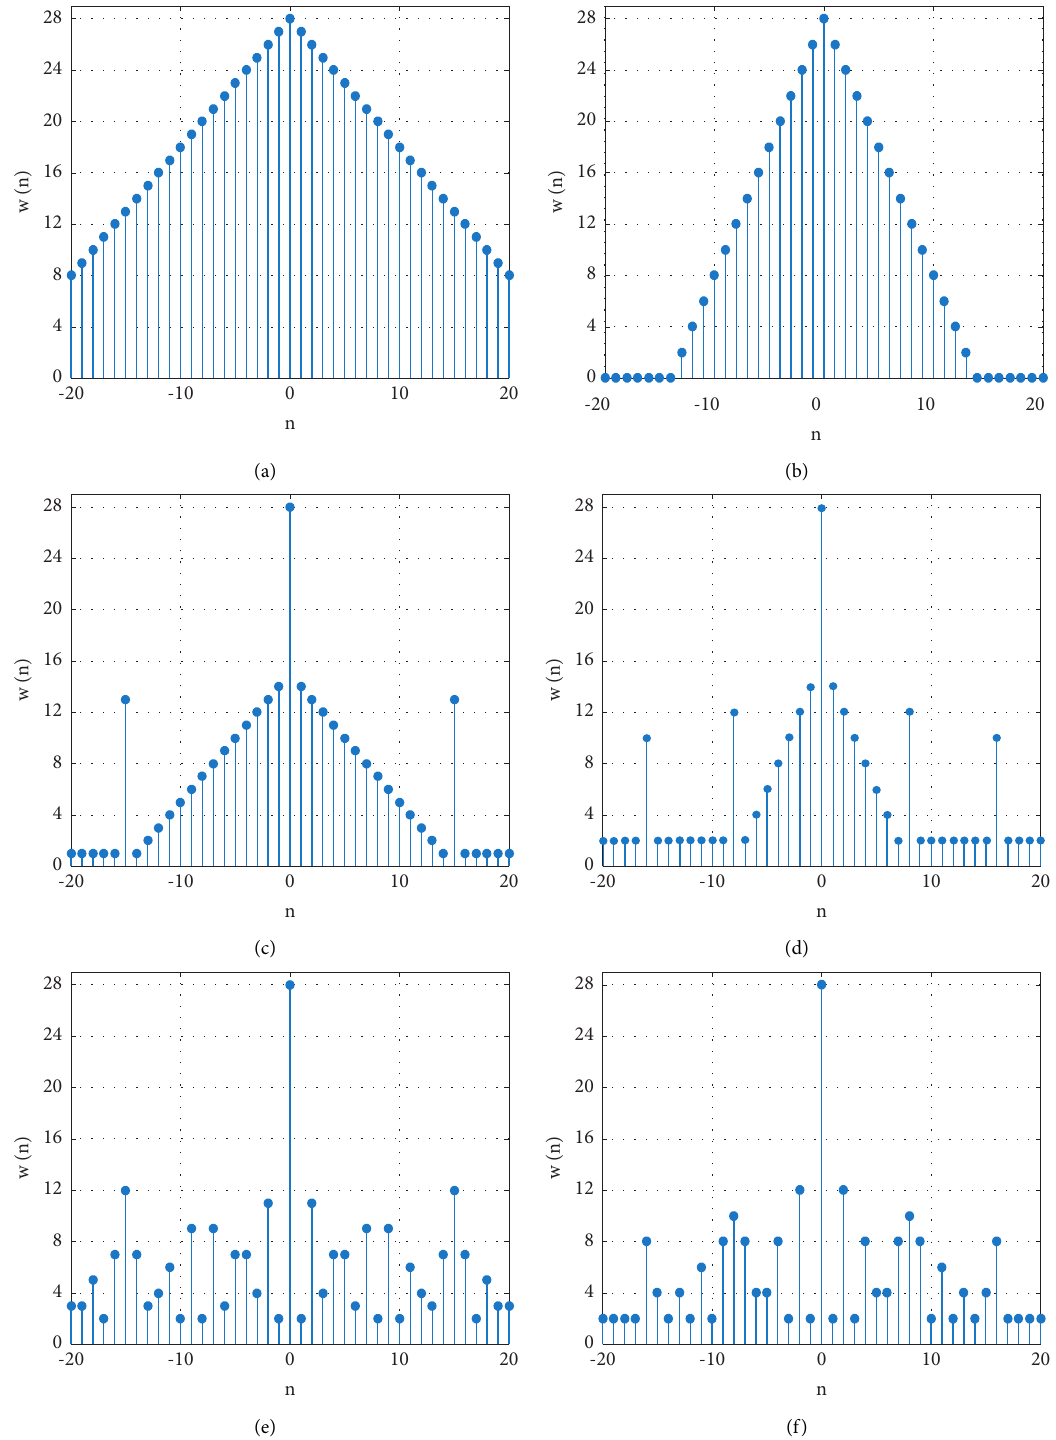
Figure 5: Weight functions. (a) ULA. (b) Distributed uniform arrays. (c) Nested arrays. (d) Distributed nested arrays. (e) Super nested arrays. (f) Distributed super nested